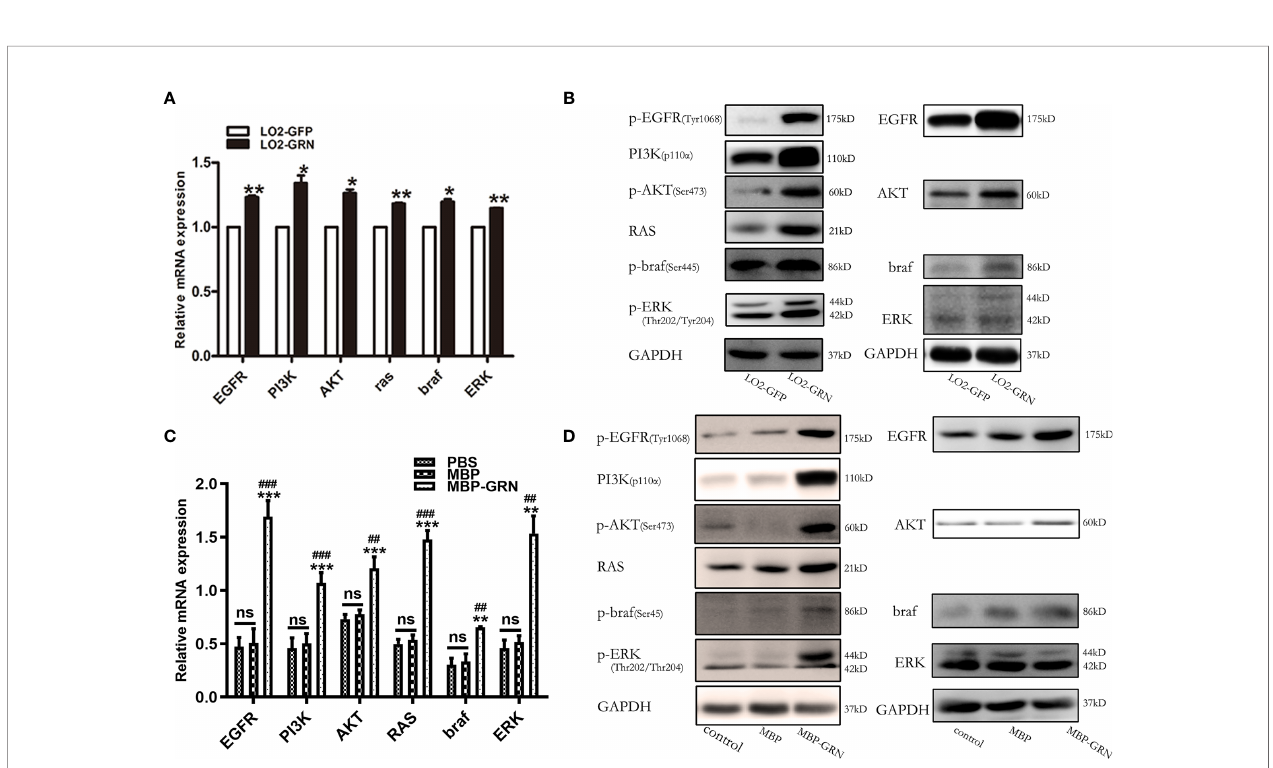
FIGURE 6 | Detection of signaling pathway markers in Cs GRN overexpression cells. (A, B) The mRNA and protein levels of RAS/MAPK/ERK and PI3K/Akt signaling pathways were detected in Cs GRN-overexpressed LO2 cells. * P < 0.05 versus control group, ** P < 0.01 versus control group. (B, D) The mRNA and protein levels of RAS/MAPK/ERK and PI3K/Akt signaling pathways were explored in recombinant Cs GRN protein – treated LO2 cells. ** P < 0.01 versus PBS group, *** P < 0.001 versus PBS group. ## P < 0.01 versus MBP group, ### P < 0.001 versus MBP group. The relative mRNA levels of the target genes were determined by q-PCR. The protein expression was determined by Western blot, and the quanti fi cation of protein expression was measured by Image J software. Three independent experiments were